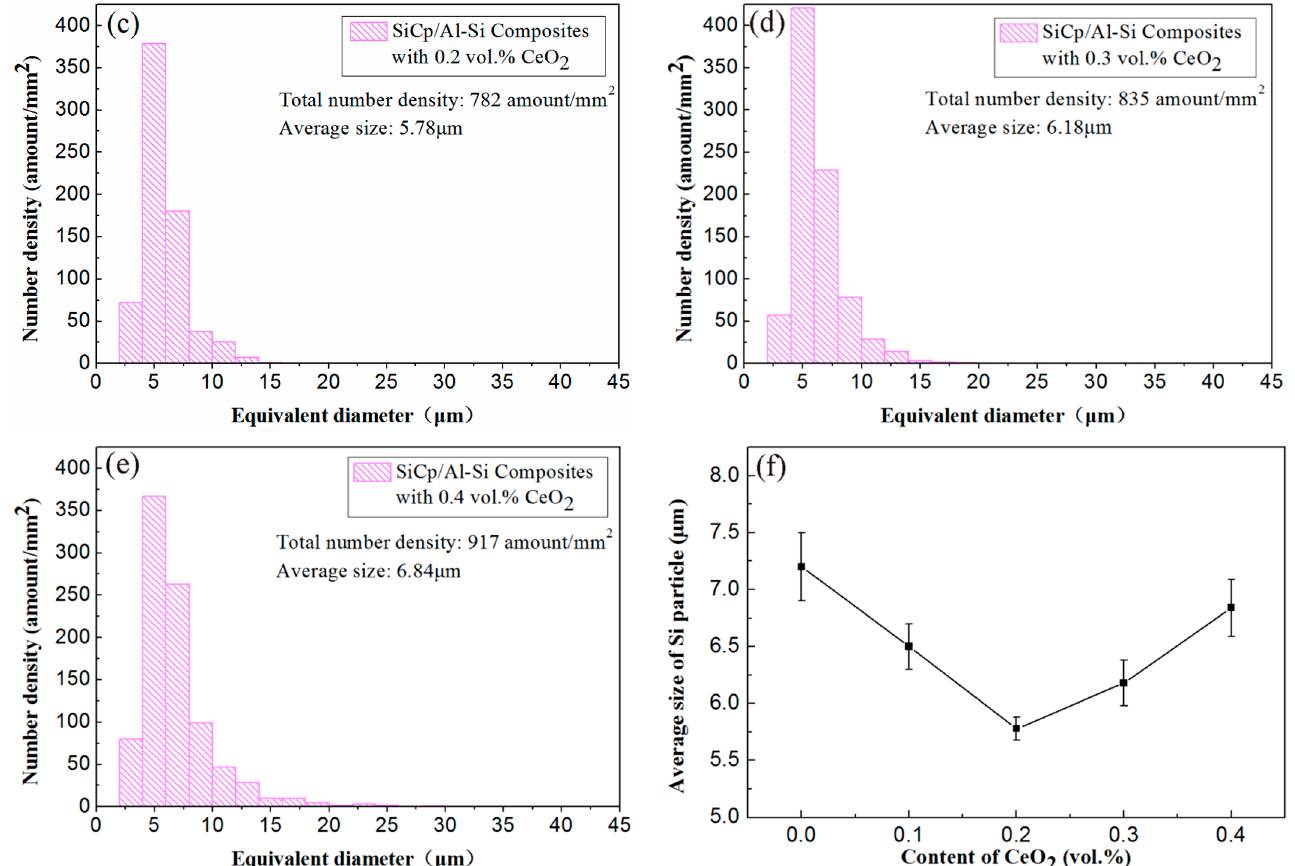
Figure 4. The number density distribution histogram and the average size of precipitated Si particles in SiCp/Al-Si composites with different CeO 2 contents: ( a ) 0; ( b ) 0.1 vol%; ( c ) 0.2 vol%; ( d ) 0.3 vol%; ( e ) 0.4 vol%; ( f ) the average size of precipitated Si particles.